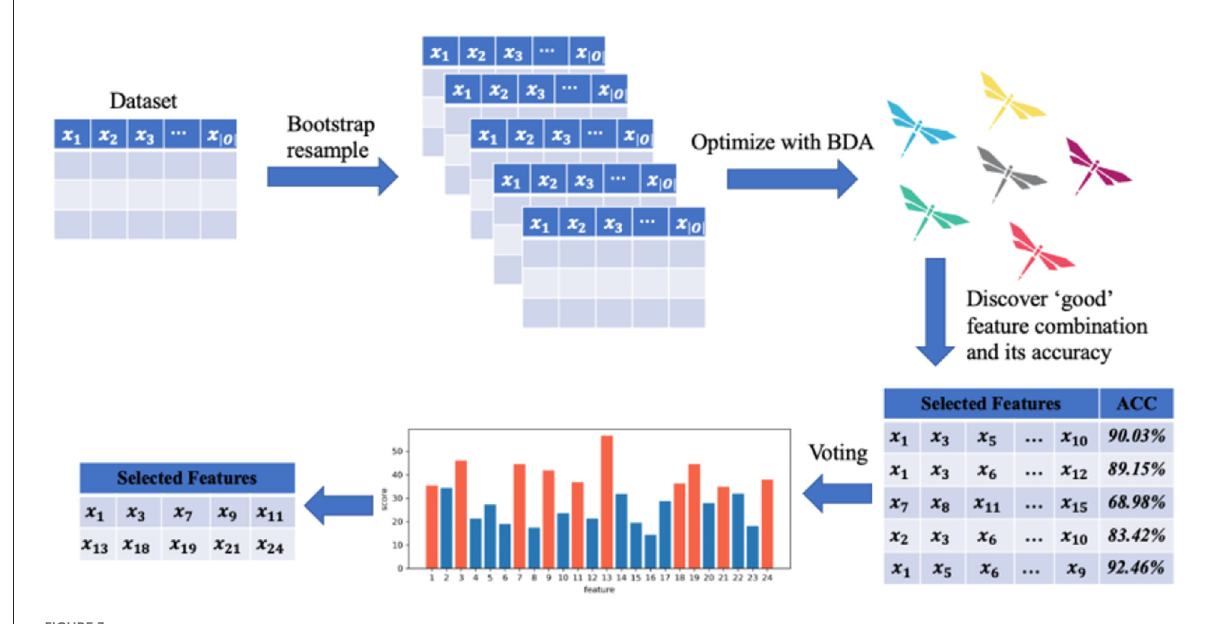
FIGURE3 The flowchart of proposed SVM based feature